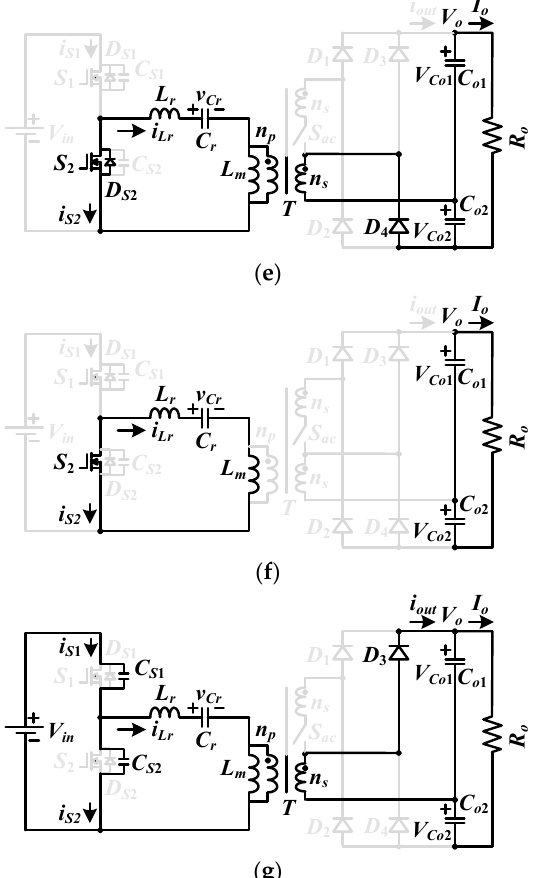
Figure 4. LLC circuits operated at high-input voltage ranges: ( a ) PWM waveforms; ( b ) mode 1; ( c ) mode 2; ( d ) mode 3; ( e ) mode 4; ( f ) mode 5; ( g ) mode 6.